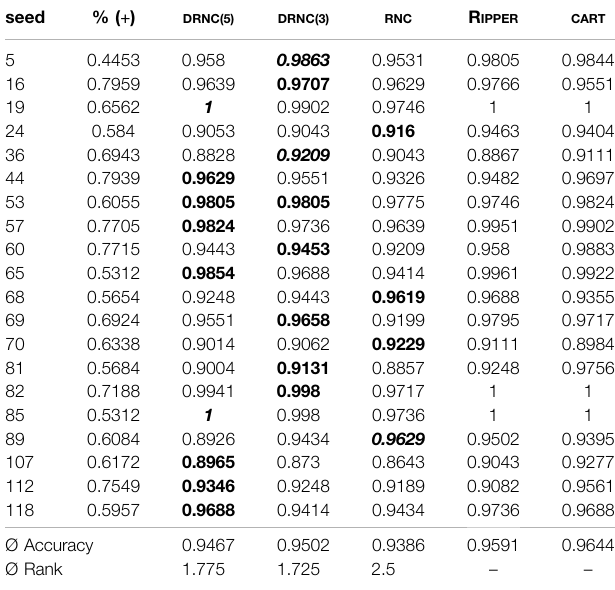
TABLE 2 | Accuracies on arti fi cial datasets. Rule network with 1/3/5 layers vs R IPPER vs CART. Thebest accuracy oftherule networks ismarked in bold,the overall best accuracy per dataset is marked in